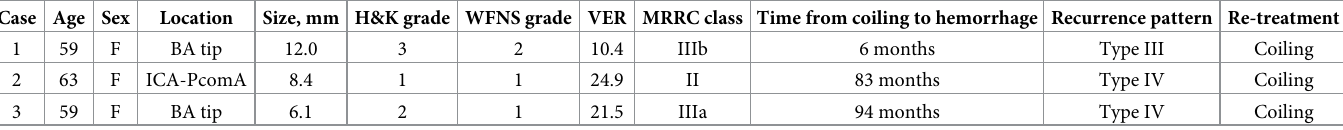
Table 4. Clinical and imaging data of the three patients with hemorrhage from recurrent aneurysm. Case Age Sex Location